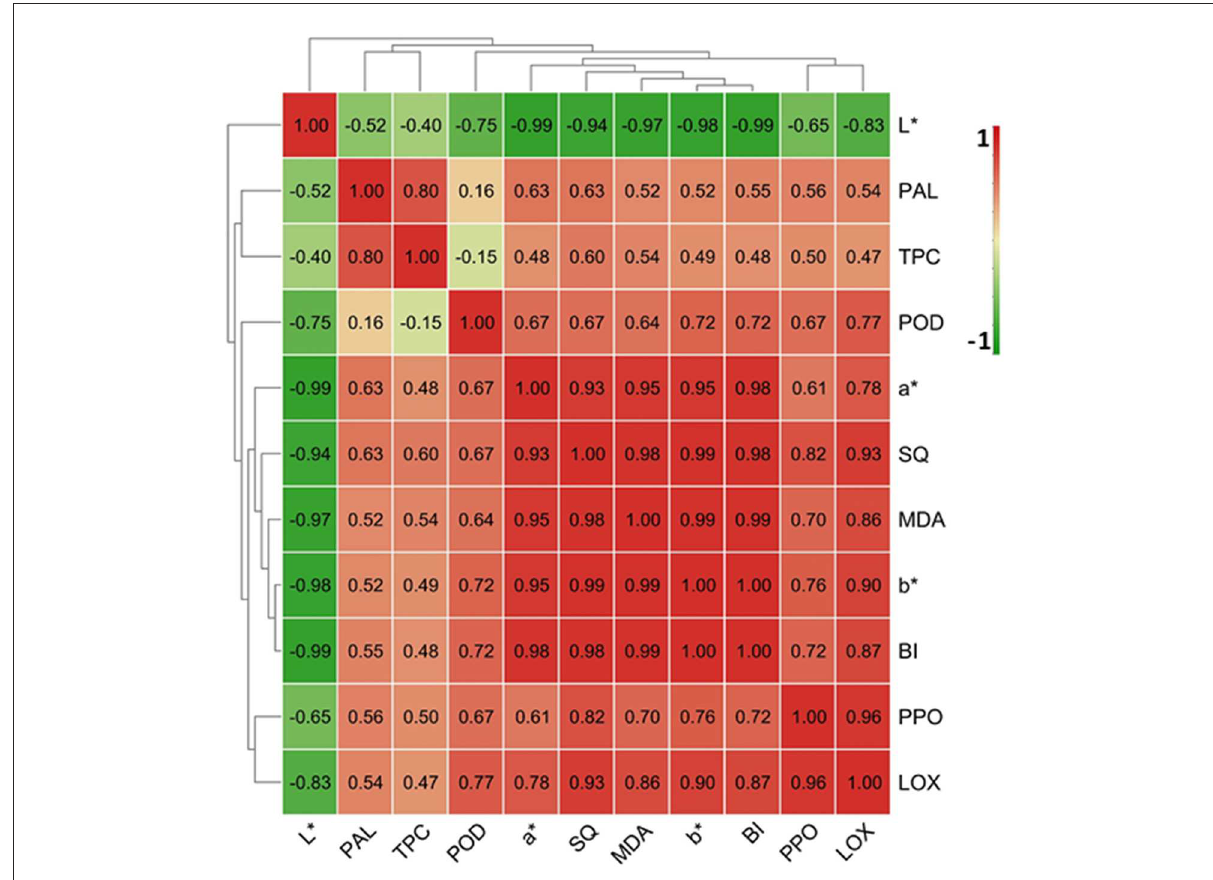
FIGURE6 Correlation analysis of browning-related indicators in fresh-cut taro during cold storage. The map was made by TBtool software (Chen et al., 2020). The correlation coefficient between two browning-related indices was indicated in the map. The color code depicted at the right side of the image ranged from − 1.0 (green) to 1.0